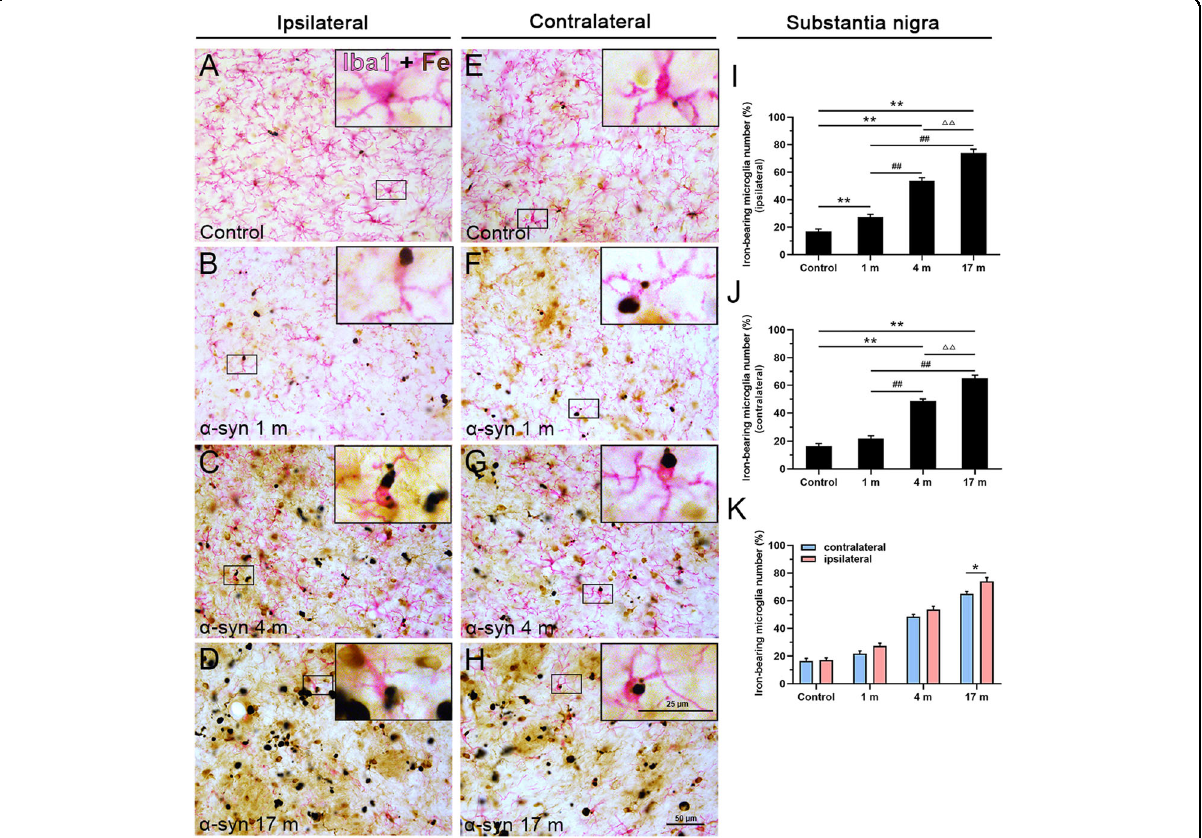
Fig. 5 Cellular localization of iron deposits in microglia of the substantia nigra. Double-labeling of chemically stained iron ions (dark brown) along with immunohistochemical staining with an Iba1 antibody (magenta) showed overlapping of iron deposition on Iba1-positive microglia in the control group ( A ) and 1, 4, and 17 months after the treatment with α -syn PFFs in the ipsilateral side ( B – D ), control group ( E ), and 1, 4, and 17 months after treatment with α -syn PFFs in the contralateral side ( F – H ). I – K Quantitative analyses of iron deposition in microglia in the substantia nigra (ipsilateral side: I ; contralateral side: J ; both sides: K ). α -Syn, α -synuclein. The data are presented as the mean ± SEM of three independent experiments. ** p < 0.01 vs. control group, ## p < 0.01 vs. 1-month group, ΔΔ p < 0.01 vs. 4-month group, one-way ANOVA ( I , J ). * p < 0.05 vs. contralateral